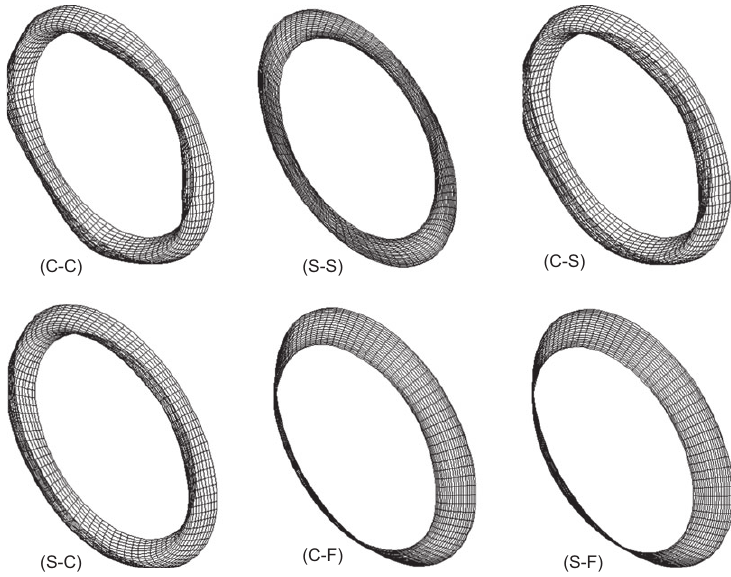
Figure 7 Mode shapes for the laminated annular circular plates (a/b =